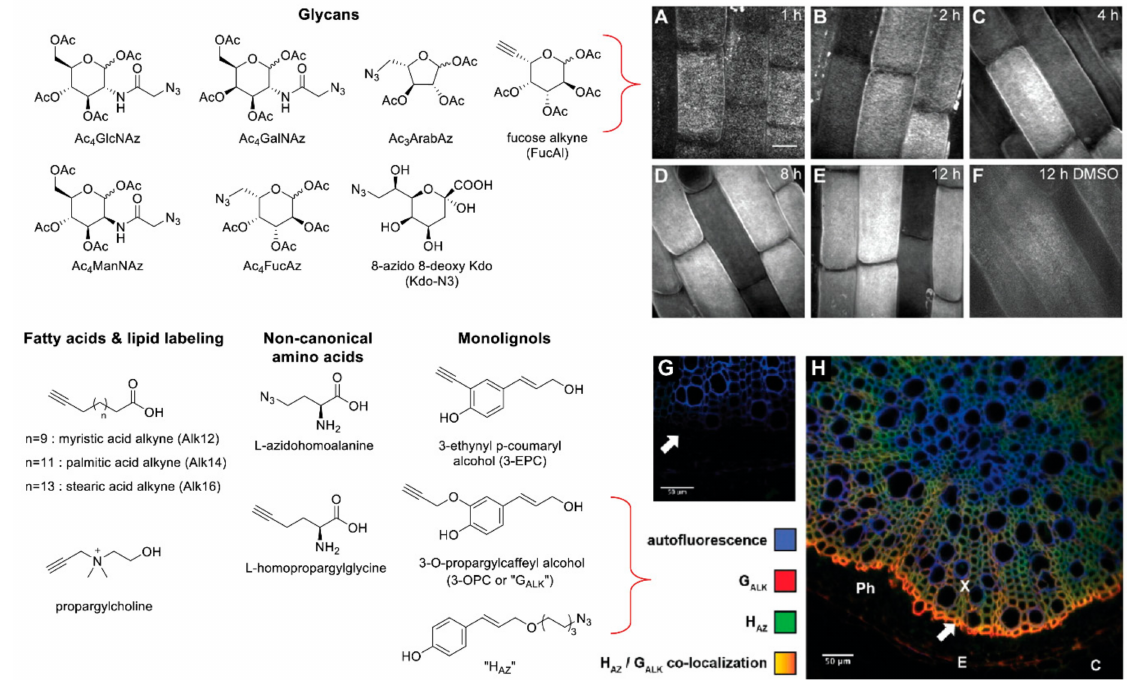
Figure 2. Structures and applications of selected azido and alkynyl reagents for metabolic labeling of plants and microbes. ( A – E ) Four-day-old Arabidopsis seedlings were treated with 2.5 µ M FucAl for the indicated times, labeled with Alexa 488-azide, and z series of elongation-zone root epidermal cells were recorded using a spinning disk confocal microscope with a 1.4 NA 100 × oil-immersion objective. Images are contrast enhanced maximum projections of the z series. ( F ) Control seedlings treated with DMSO for 12 h and labeled with Alexa 488-azide show background fluorescence. (Scale bars, 10 µ m) [25]. ( G , H ) Bioorthogonal Labeling Imaging Sequential Strategy (BLISS) illustrating incorporation of monolignol chemical reporters “G ALK ” and “H AZ ” into cell walls in 2-month-old flax roots. Sectioned flax roots previously incubated with native p-coumaryl and coniferyl alcohols as negative control (G) or with azide-labeled p-coumaryl alcohol (H AZ ) and alkyne-labeled coniferyl alcohol (G ALK ) monolignol reporters (H) and observed by confocal microscopy [23]. Images and portions of the caption reprinted (adapted) from Anderson, C.T.; Wallace, I.S.; Somerville; C.R . Proc. Natl. Acad. Sci. USA 2012 , 109 , 1329–1334 under the PNAS License to Publish, and from Simon, C.; Lion, C.; Huss, B.; Blervacq, A.S.;